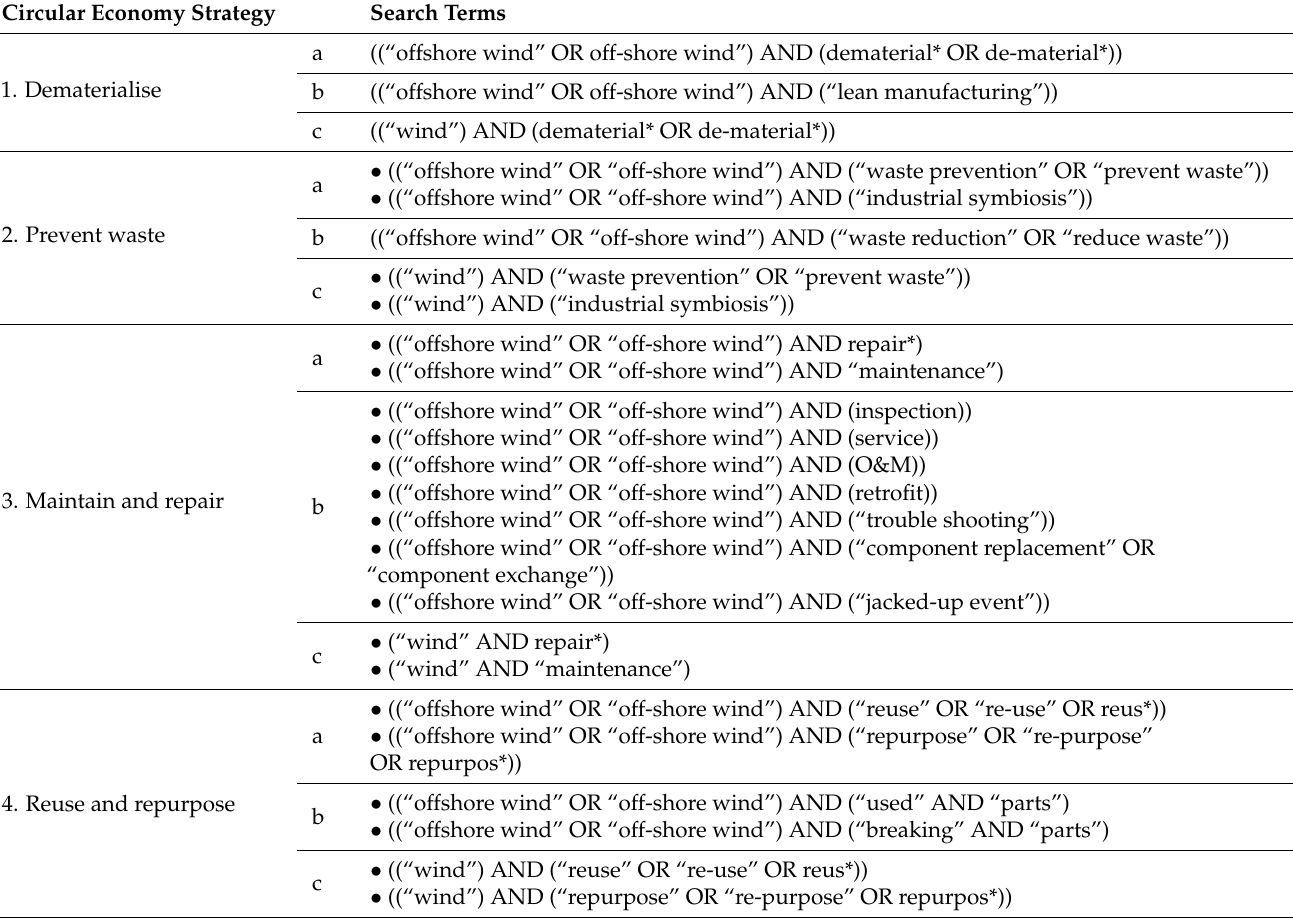
Table 3. Literature searches for keywords in the publication title, abstract or keywords on Scopus (last repeated on 5 and 6 June 2021, unless specified otherwise) for three consecutive searches on (a) circular economy strategies in offshore wind, (b) associated terms in offshore wind based on Table 2 and (c) circular economy strategies in wind energy in general. Circular Economy